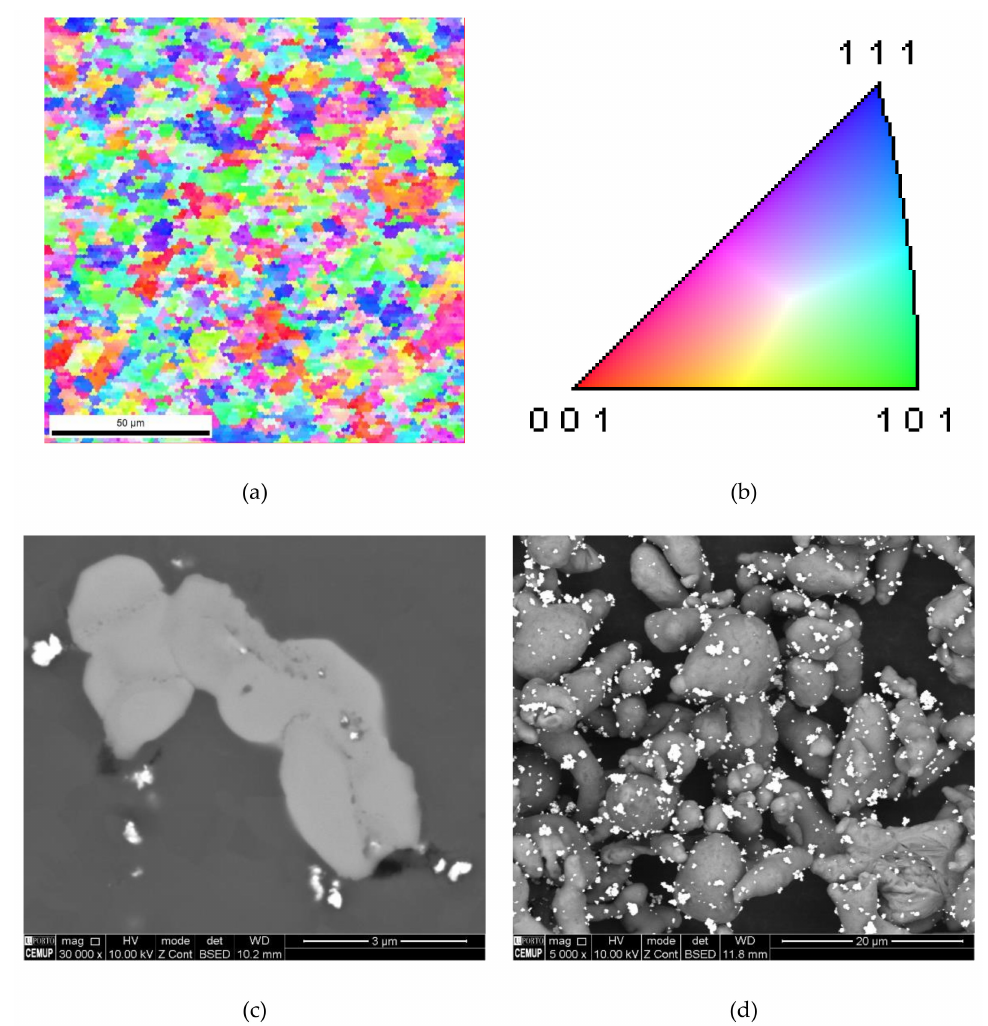
Figure 9. ( a ) and ( b ) SEM/EBSD analysis illustrating the IPF and coded map of the Al matrix; ( c ) SEM/BSE images illustrating the WC and the phase formed after sintering; and ( d ) distribution of WC in Al